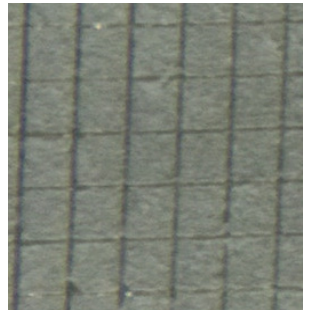
Figure 7. Crosshatch tape adhesion test for the composite